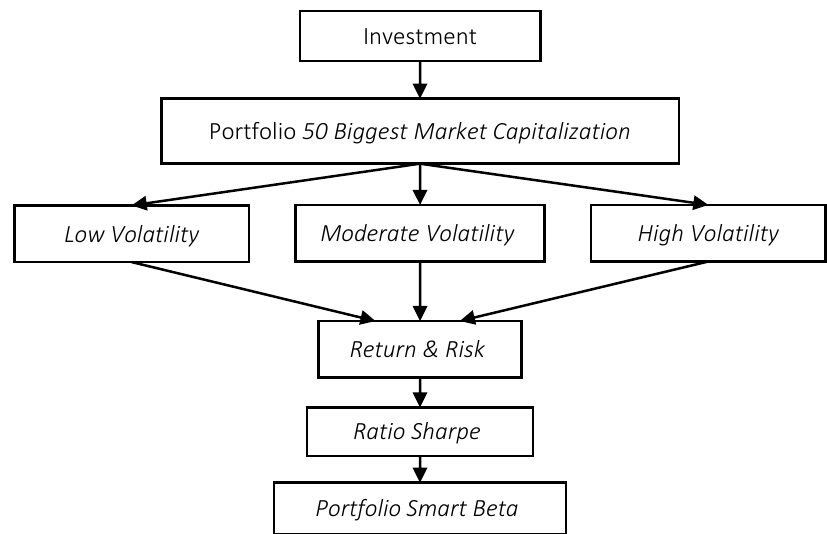
Figure 1. Research